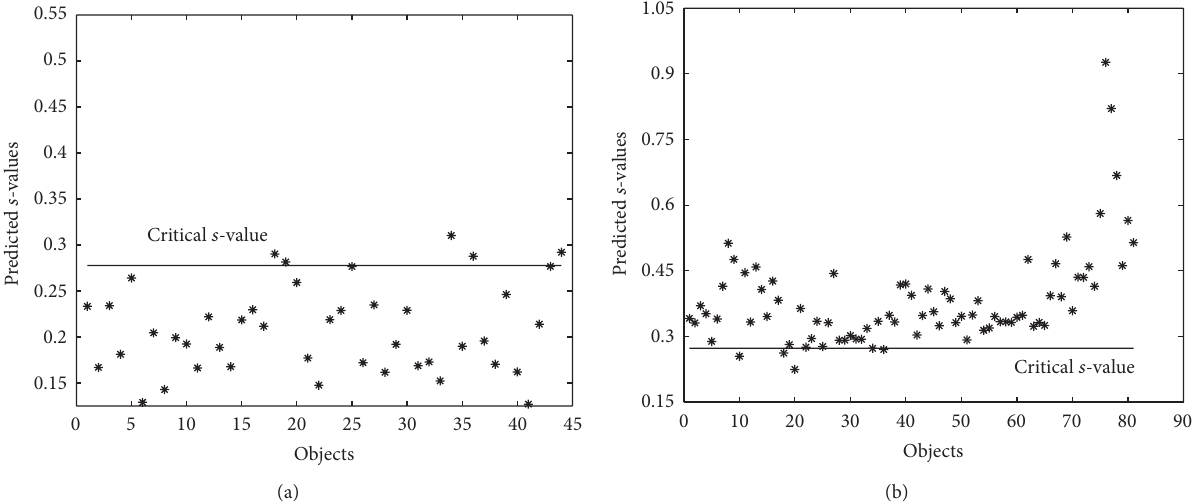
F 5: Results obtained by SNV-SIMCA with 7 principal components for (a) 44 positive test objects, and (b) 81 negative test objects.